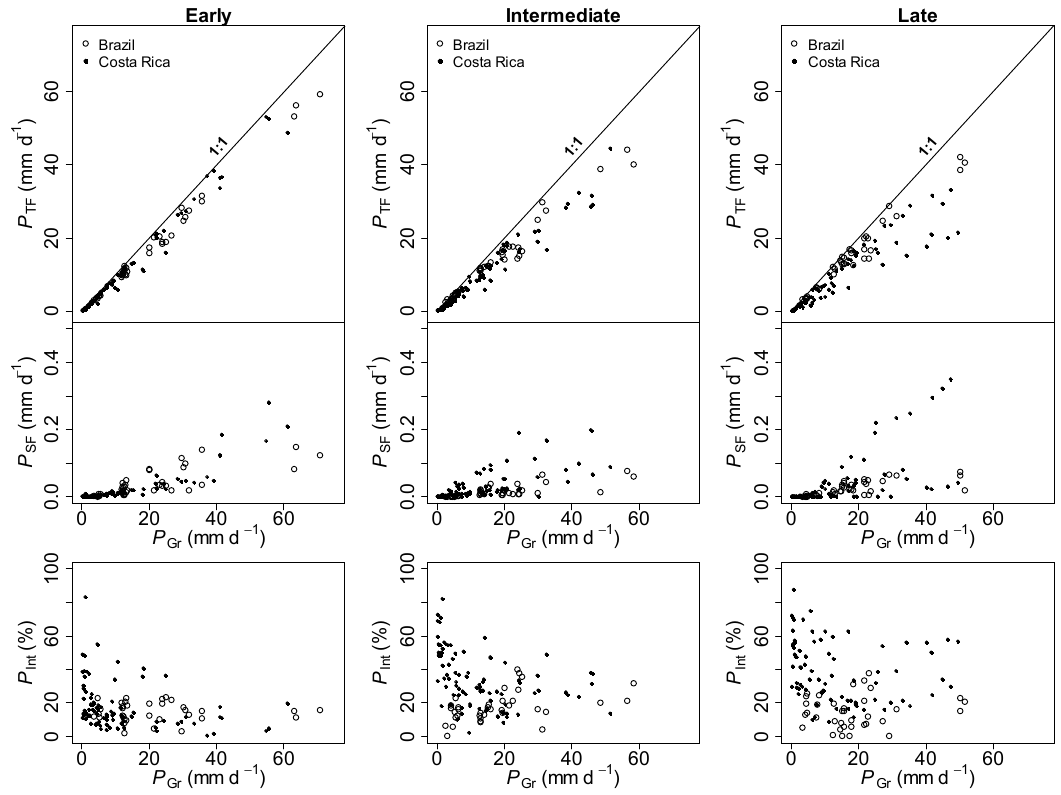
Figure 2. Daily fluxes of throughfall and stemflow fluxes with respect to rainfall among successional stages of tropical dry forest in Costa Rica and Brazil.